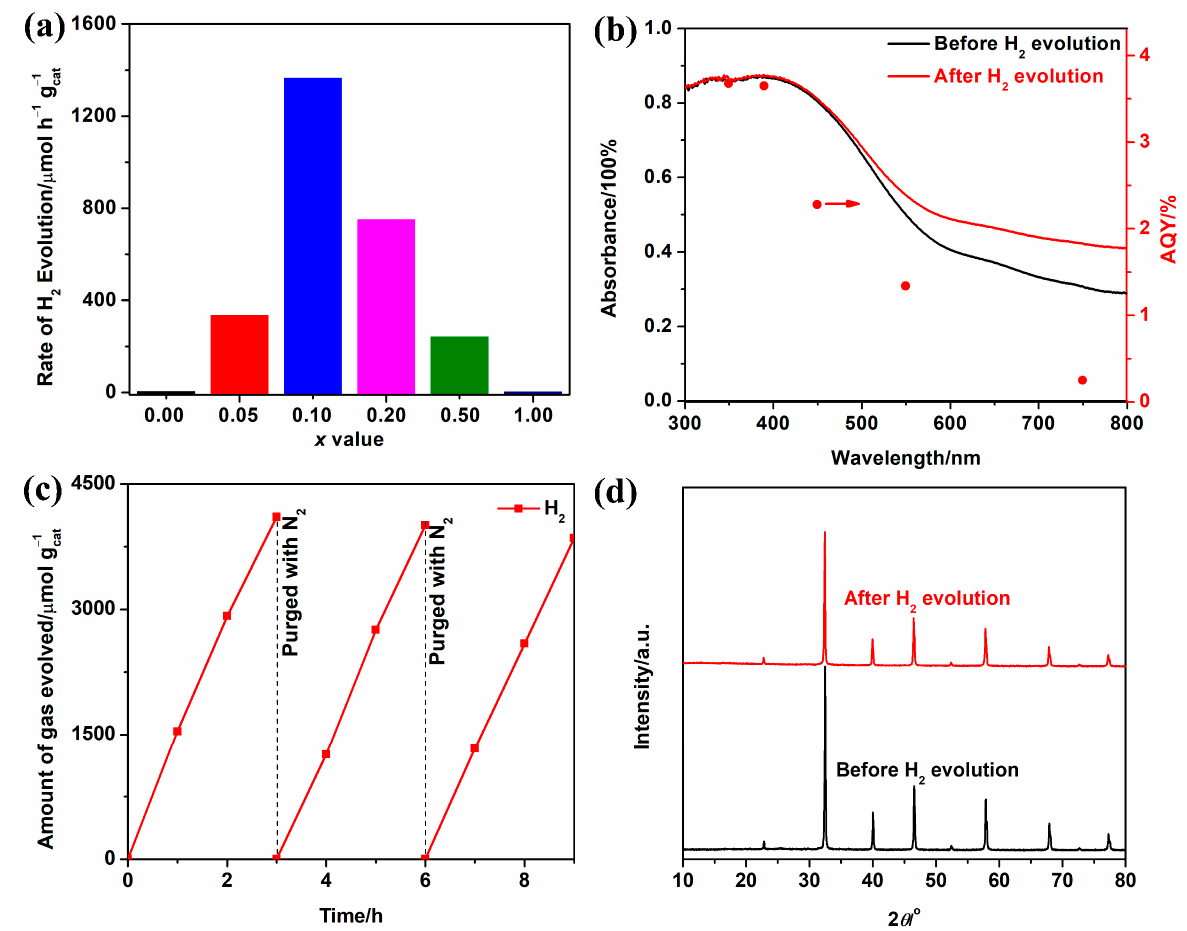
Figure 5. ( a ) Photocatalytic H 2 evolution of the as-prepared SrLaTiCrO- x samples with x equal to 0.00, 0.05, 0.10, 0.20, 0.50 and 1.00 under visible light irradiation. ( b ) Wavelength-dependent AQY and UV–Vis spectra of the as-prepared SrLaTiCrO-0.10 before and after photocatalytic H 2 evolution. ( c ) Cyclic tests for SrLaTiCrO-0.10. ( d ) XRD patterns of SrLaTiCrO-0.10 before and after photocata- lytic H 2 evolution.